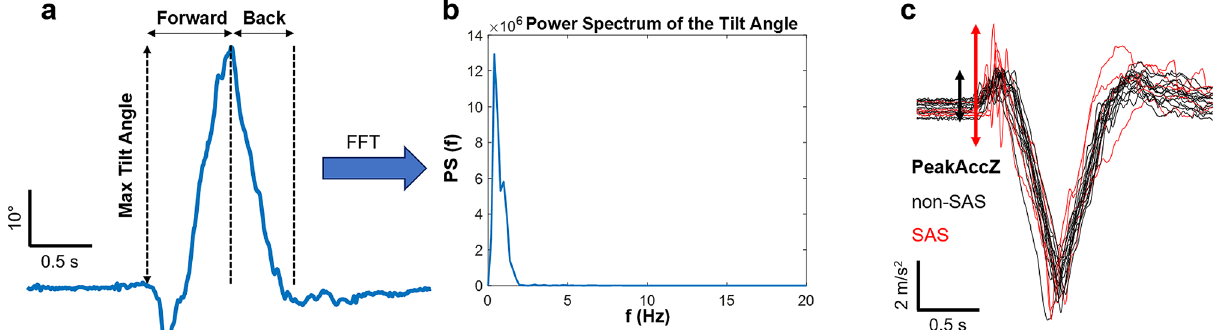
Figure 2. Example of the raw trunk tilt angle signal, θ , derived from the triaxial accelerometry of the smartphone ( a ), the power spectrum of this angle signal ( b ), and the z-axis accelerometer data showing the peak at the beginning of the movement ( PeakAccZ ) for non-SAS trials (black) and SAS trials (red) ( c